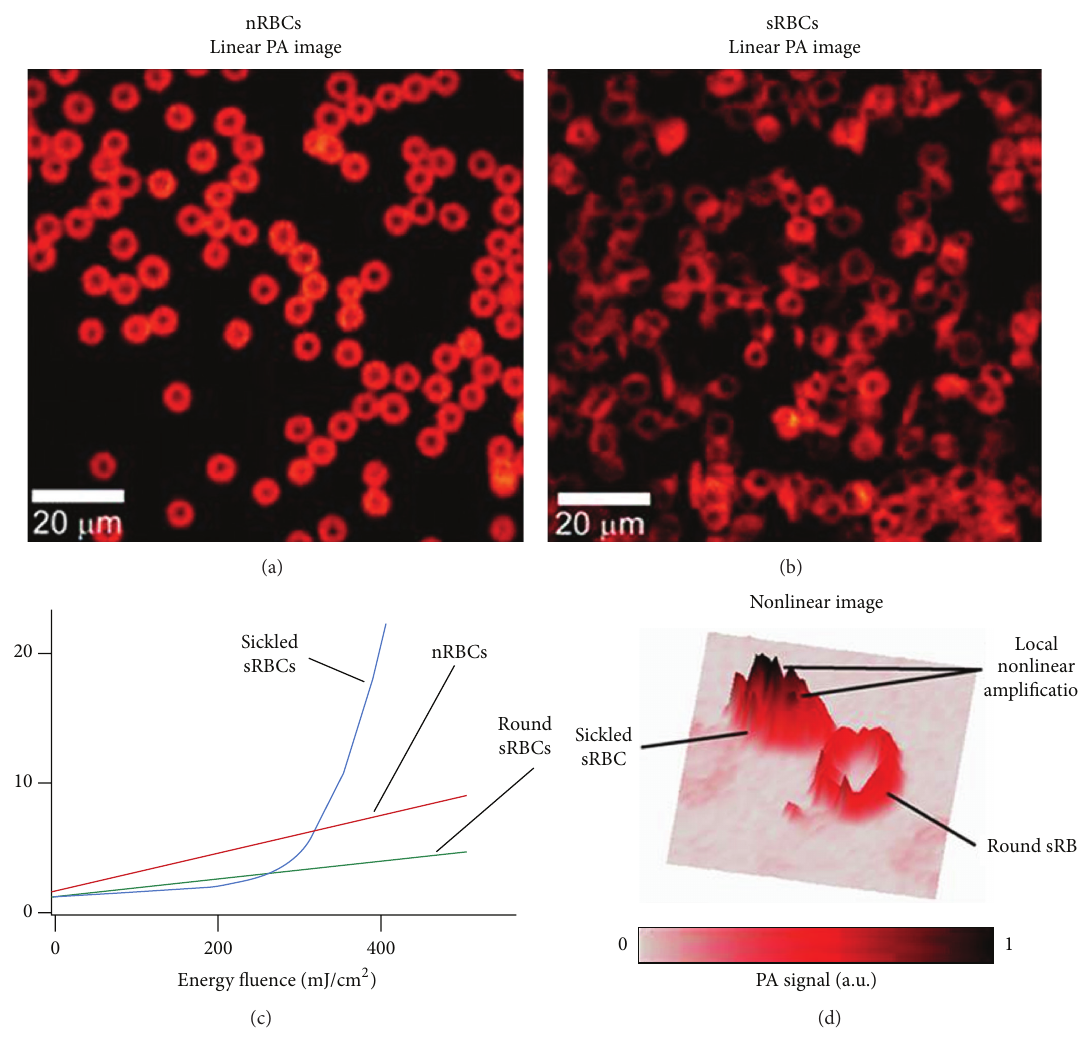
Figure 5: PA imaging of nRBCs and sRBCs in vitro . (a, b) PA images of nRBCs (a) and sRBCs (b) in glass slides. (c) The dependence of PA signal amplitudes on laser energy fluence for single RBCs with different states and shapes demonstrating linear behavior for nRBCs and round sRBCs and nonlinear signal amplification for sRBCs with deformed shape. Data represents average PA signals from 50 cells. (d) PA images of two sRBCs at relatively high energy fluence demonstrating more profound nonlinear nanobubble-based amplification of PA signals from sRBC with deformed shape. Laser parameters: wavelength, 532 nm (a–d); energy fluence, 50 mJ/cm 2 (a, b) and 400 mJ/cm 2